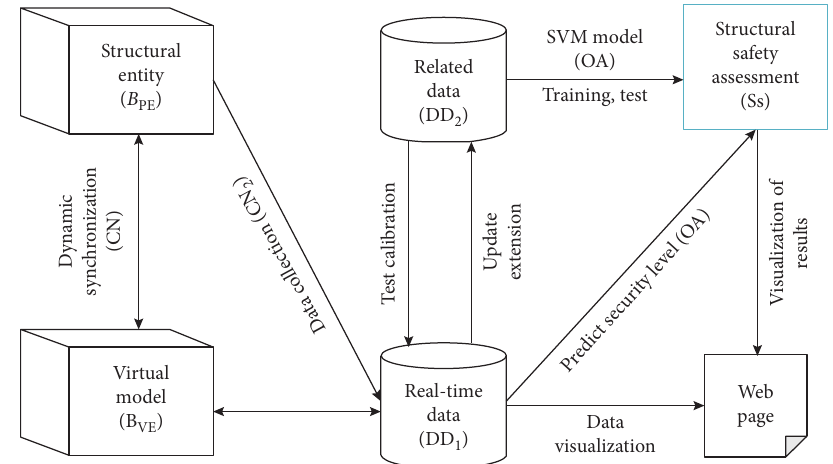
Figure 5: Safety evaluation system framework.